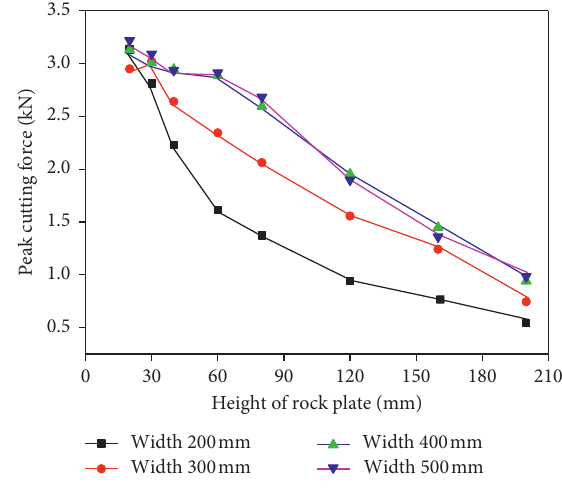
Figure 12: Variations in PCF with width.